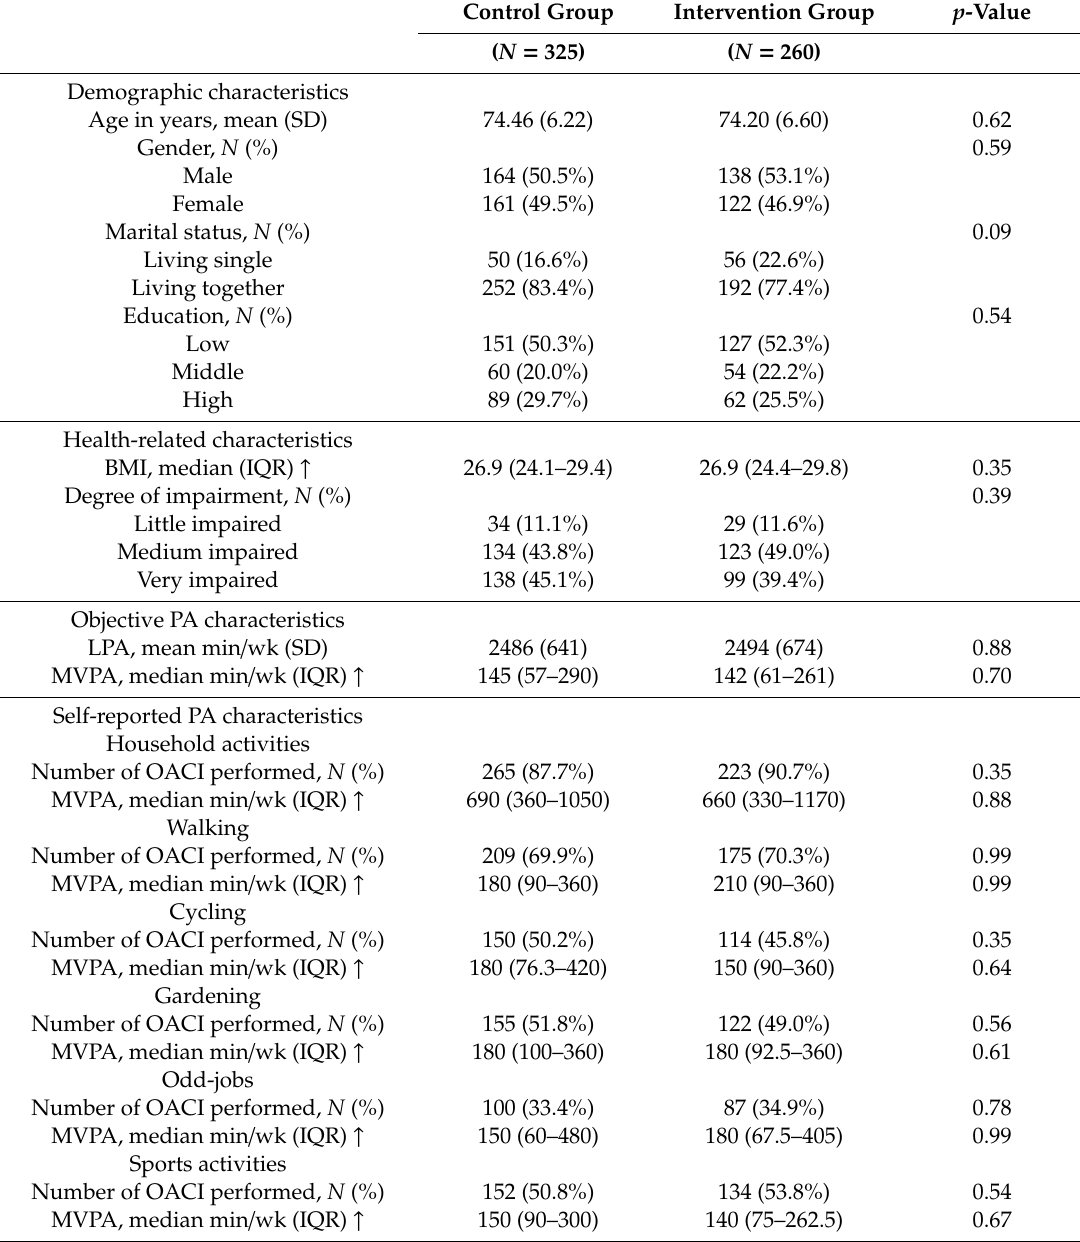
Table 1. Baseline participant characteristics of the control group and the intervention